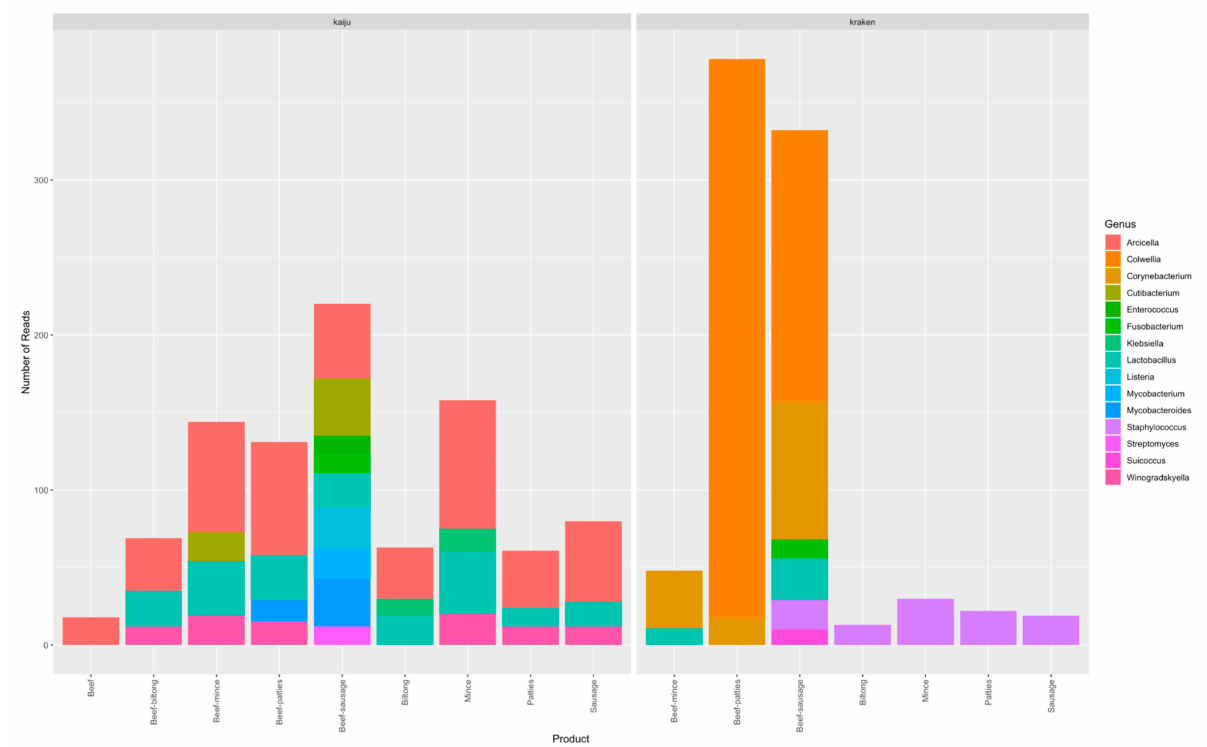
Figure 1. Number of reads ( n ≥ 10) assigned to different genera obtained from various product